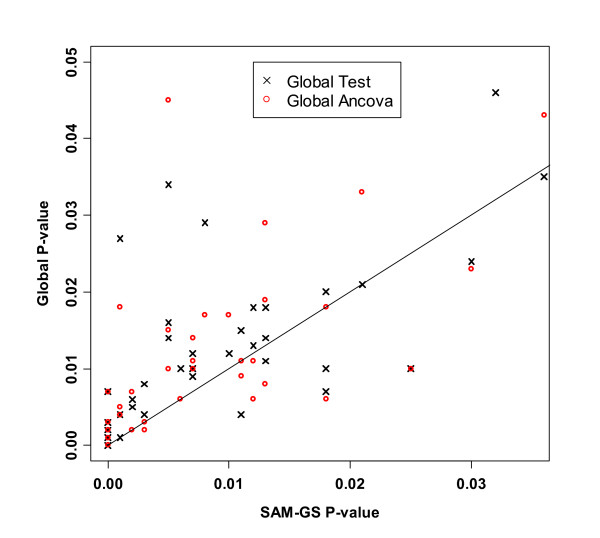
Lowest P-values in the p53 data analysis: p-values of Global Test and ANCOVA Global Test after standardization vs. SAM-GS p-values before the standardization. The line indicates equal p-values between SAM-GS and Global Tests.